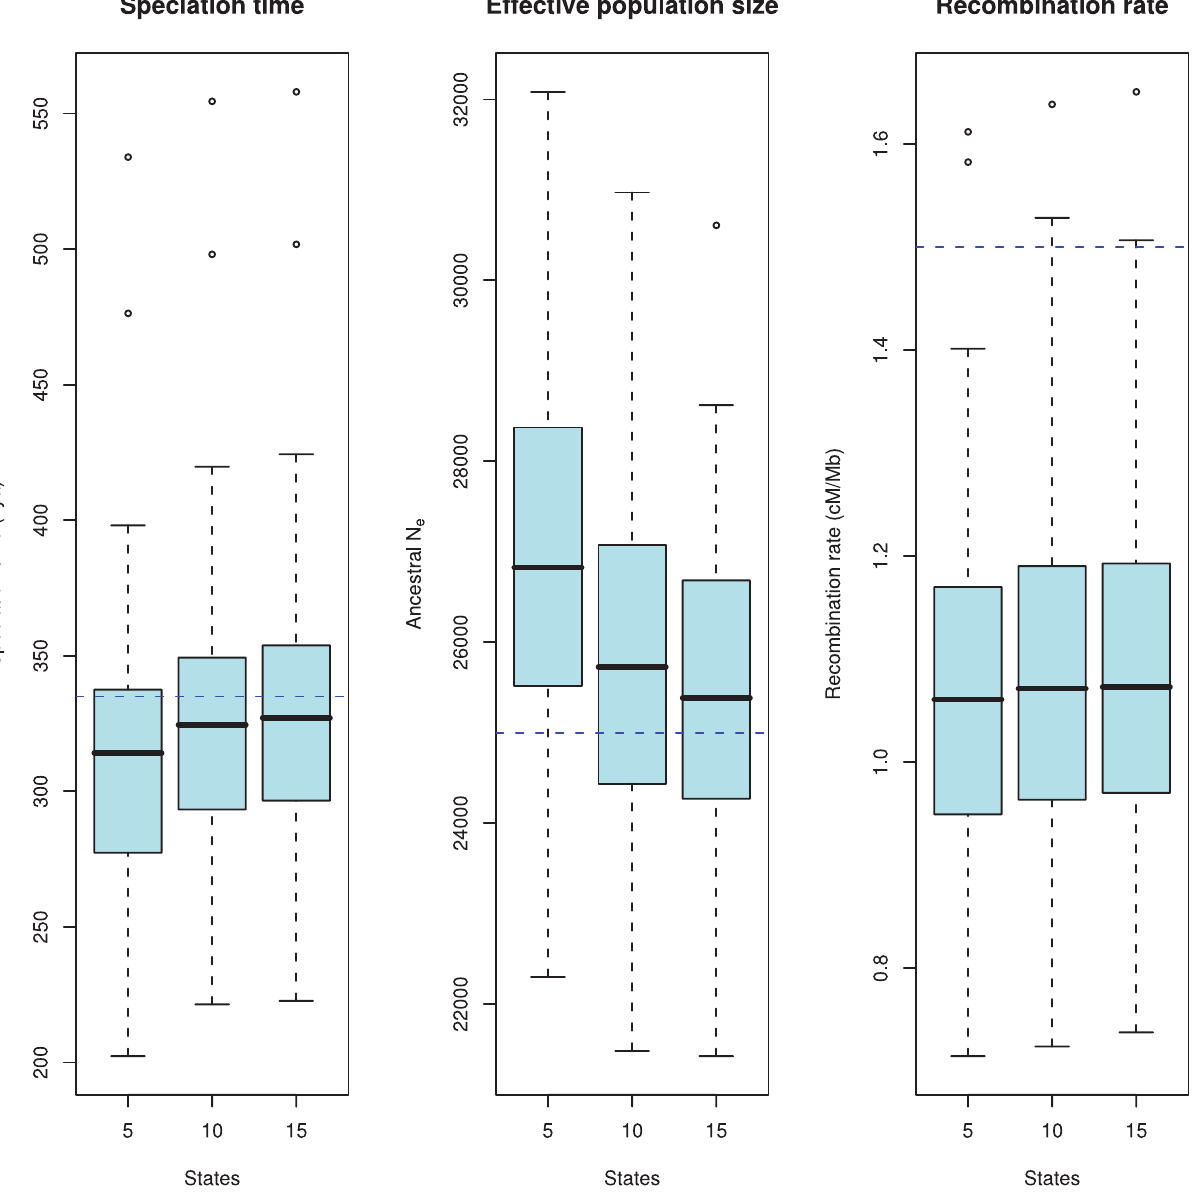
Figure 8. Estimation accuracy as a function of the number of hidden states. The boxplots show the estimated parameters (divergence time, ancestral effective population size, and recombination rate) for 100 simulated data sets. The true value is showed as the blue dashed line. The number of states in the HMM, i.e. the number of coalescence time intervals used for the estimation takes the values 5, 10 and 15. There is a clear bias in the estimates where we tend to underestimate the divergence time and overestimate the effective population size. This bias is caused by the discretisation of continuous coalescence times into fixed intervals, and the bias is reduced as the number of states (i.e. intervals) increases. The recombination rate is under-estimated, which is a consequence of the Markov